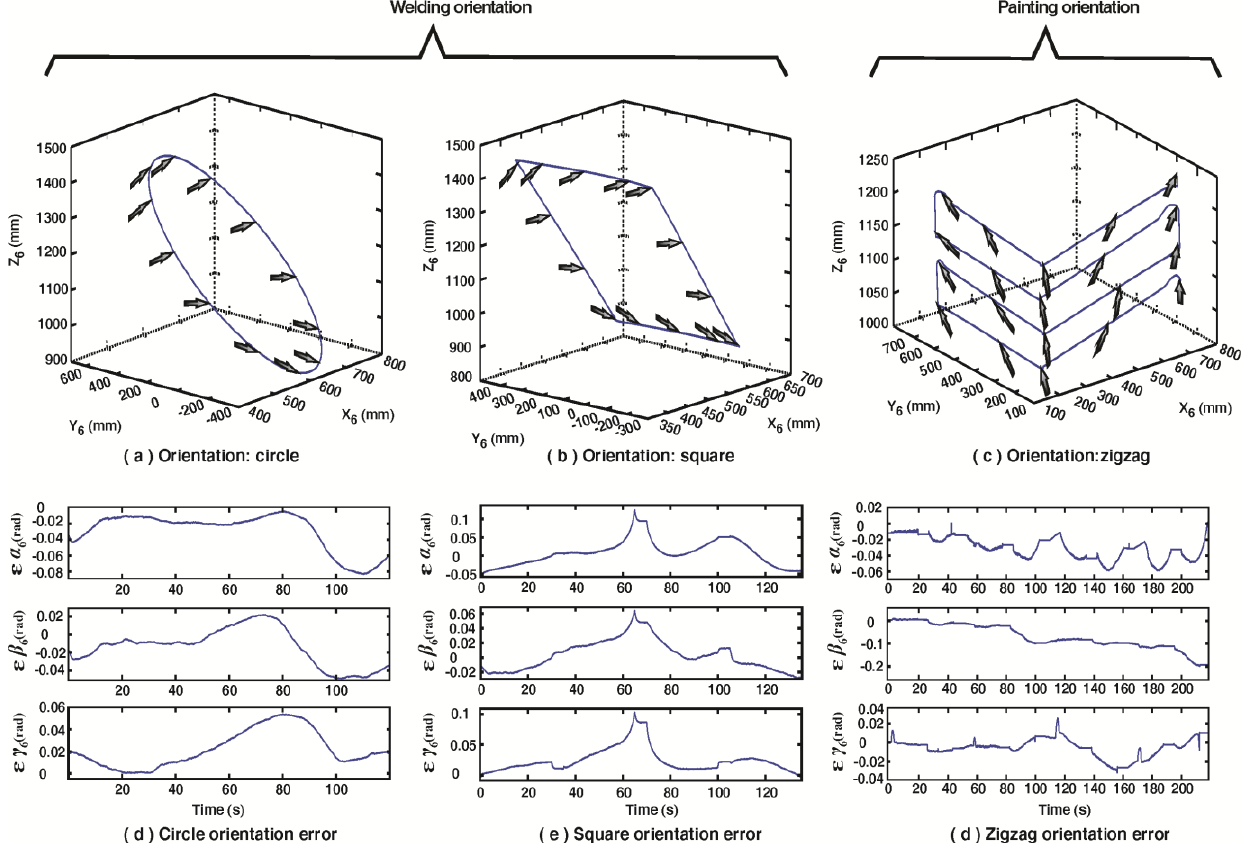
Figure 14. Monitored end effector orientation for welding and painting paths, (a) circle path, (b) square path, (c) zigzag path; Orientation errors for (d) circle path, (e) square path and (f) zigzag path.